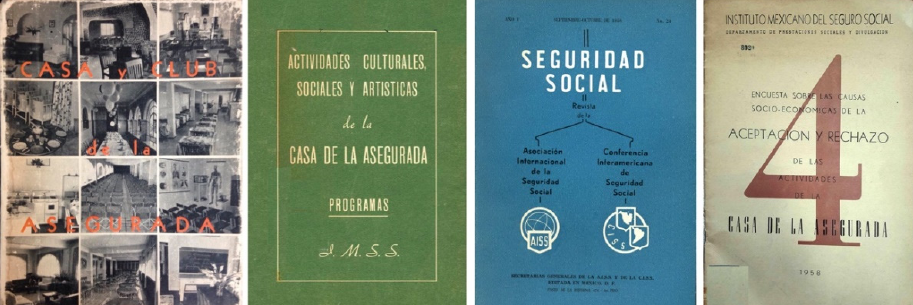
Figure 1. Covers of some of the documents about the Casa de la Asegurada located in the library of the Interamerican Center of Social Security Studies (CIESS). From left to right: [10–13]. Source: own creation. 2021.